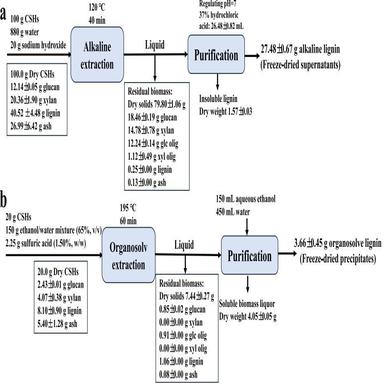
Comparative mass balance analysis of lignin preparation from CSHs via alkaline (a) and organosolv (b) extraction methods.